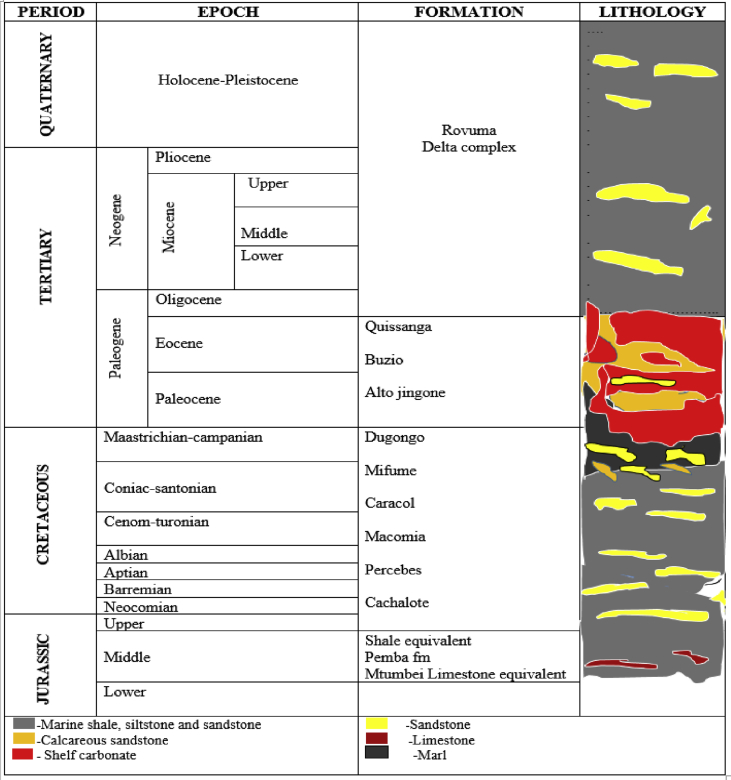
Summary of Rovuma Basin stratigraphy offshore Mozambique (Modified from Key et al., 2008 and Mahanjane and Franke, 2014).